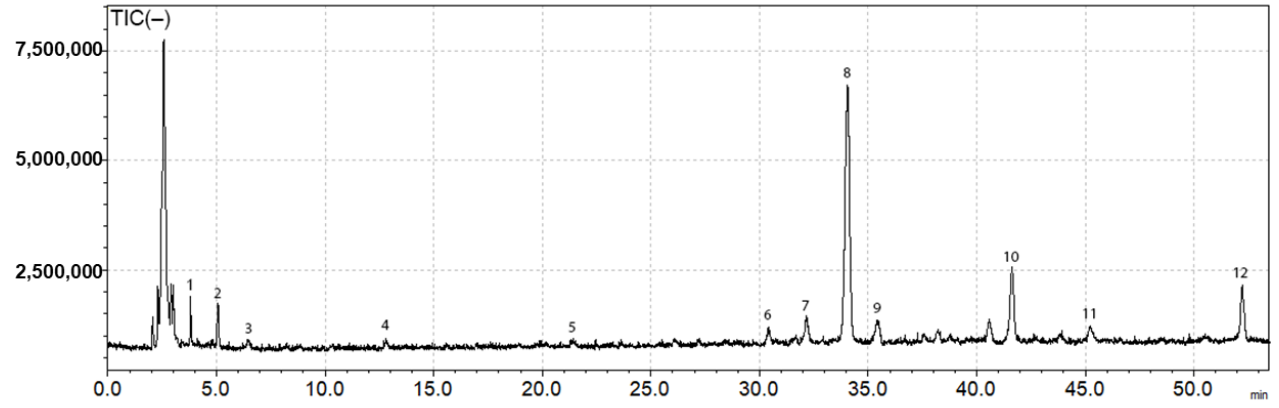
Figure 1. Total ion chromatogram (TIC) of M. officinalis extract in negative ionization mode . Table 1. Phenolic compounds tentatively identified in M. officinalis extract by LC-MS in negative ionization mode.